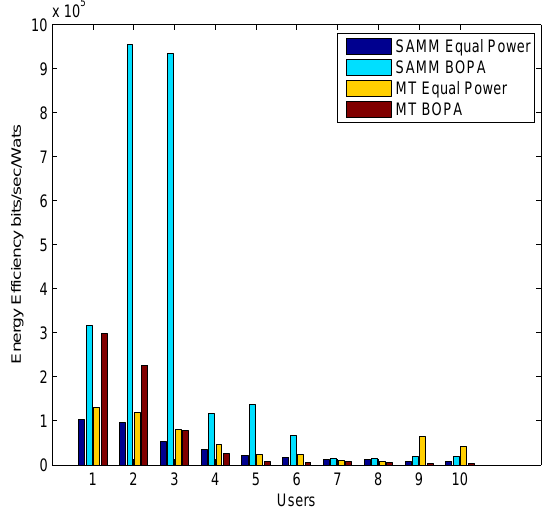
Figure 4. Users vs. Energy Efficiency (bits per second per watts) for all four schemes.